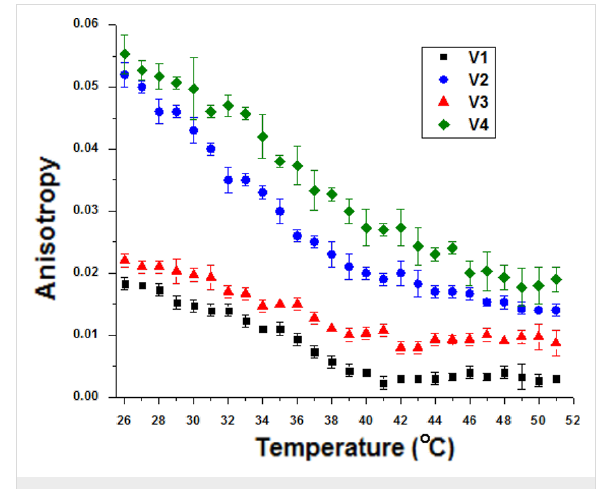
Figure 4: The thermal behavior of the emission anisotropy of Chl a in the samples.